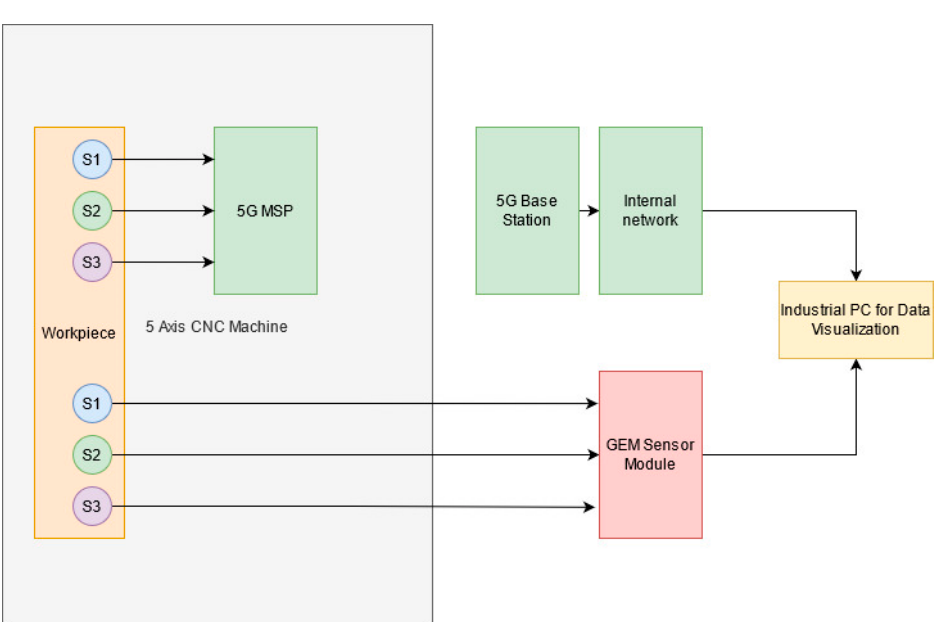
Figure 4. Experimental setup with MSP, wired sensor, and visualization PC.